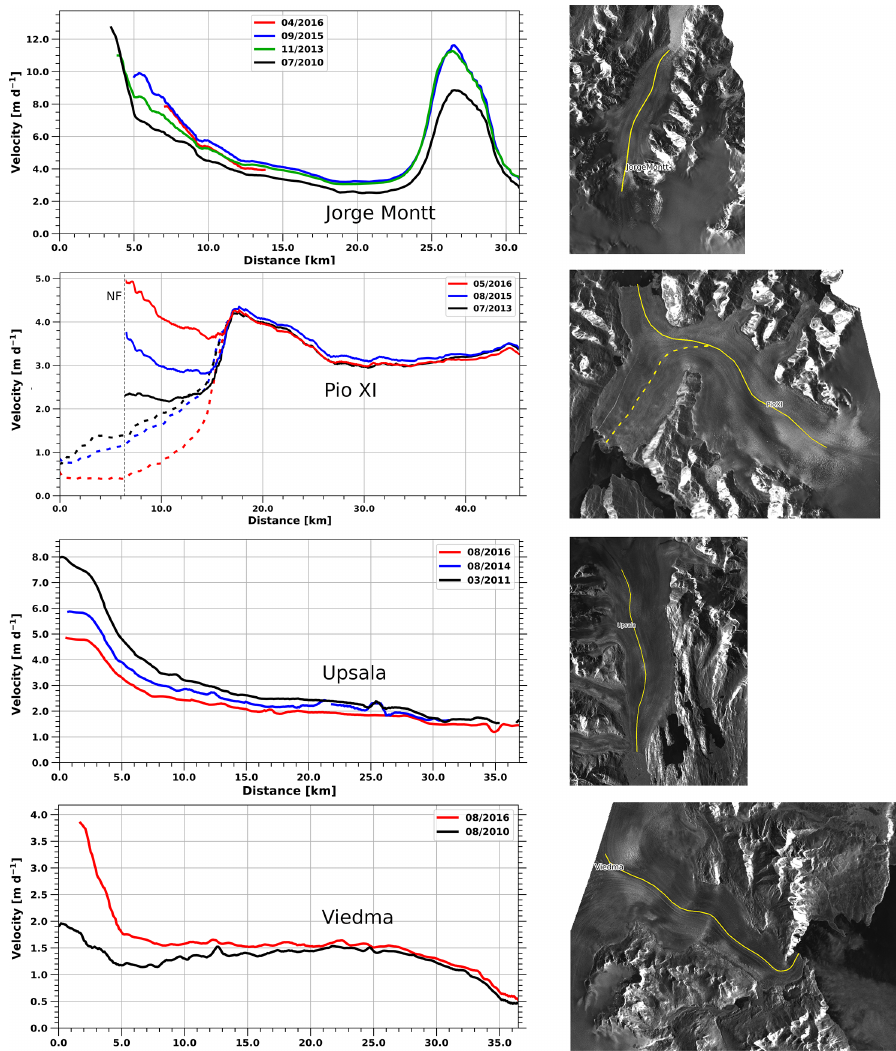
Figure 11. Surface velocities along the central flow lines of Jorge Montt, Pio XI, Upsala and Viedma glaciers (SPI) on different dates, derived from TerraSAR-X repeat pass data. The distance origin refers to the ice front position on the first date: for Pio XI Glacier to the front of the southern branch and for NF to the front of the northern branch. Pio XI Glacier, dashed lines: velocities along the central flow line of the southern branch. Insets: TerraSAR-X images with location of central flow